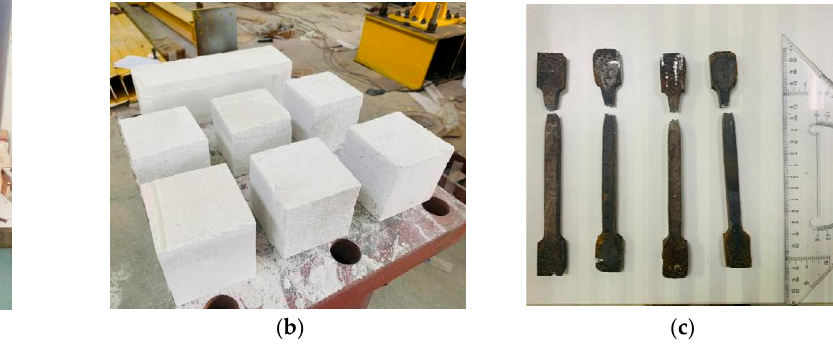
Figure 6. Material properties test: ( a ) Universal testing machine, ( b ) ALC test blocks, ( c ) Test steel coupons. Table 2. Material properties of